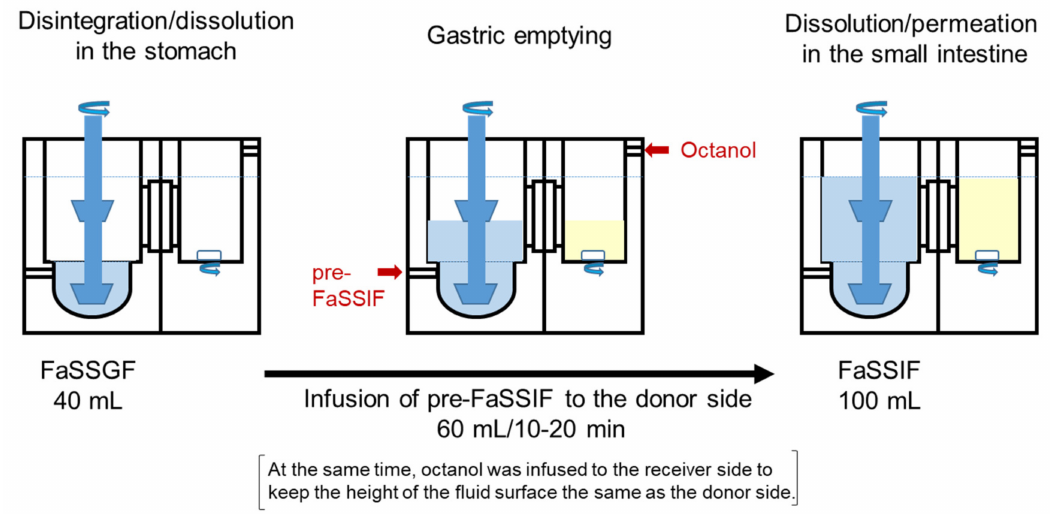
Figure 2. Experimental conditions represent the GI physiology in the fasted state in the BE